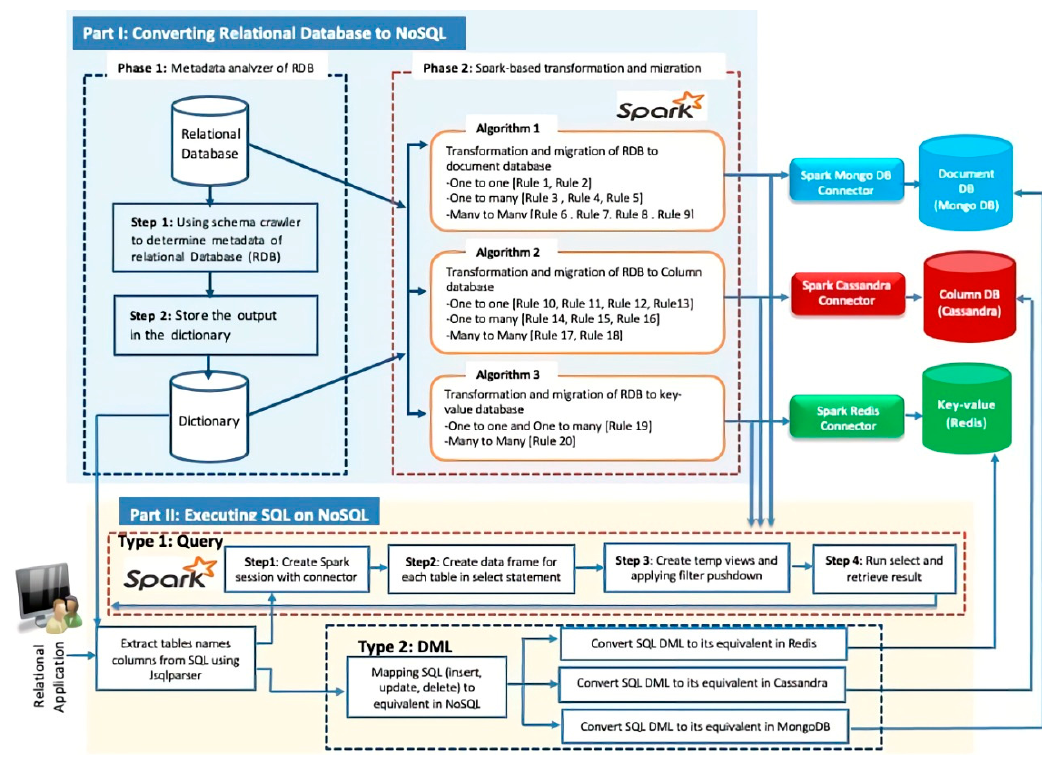
Figure 1. The architecture of the proposed Spark-based layer (created by the author).